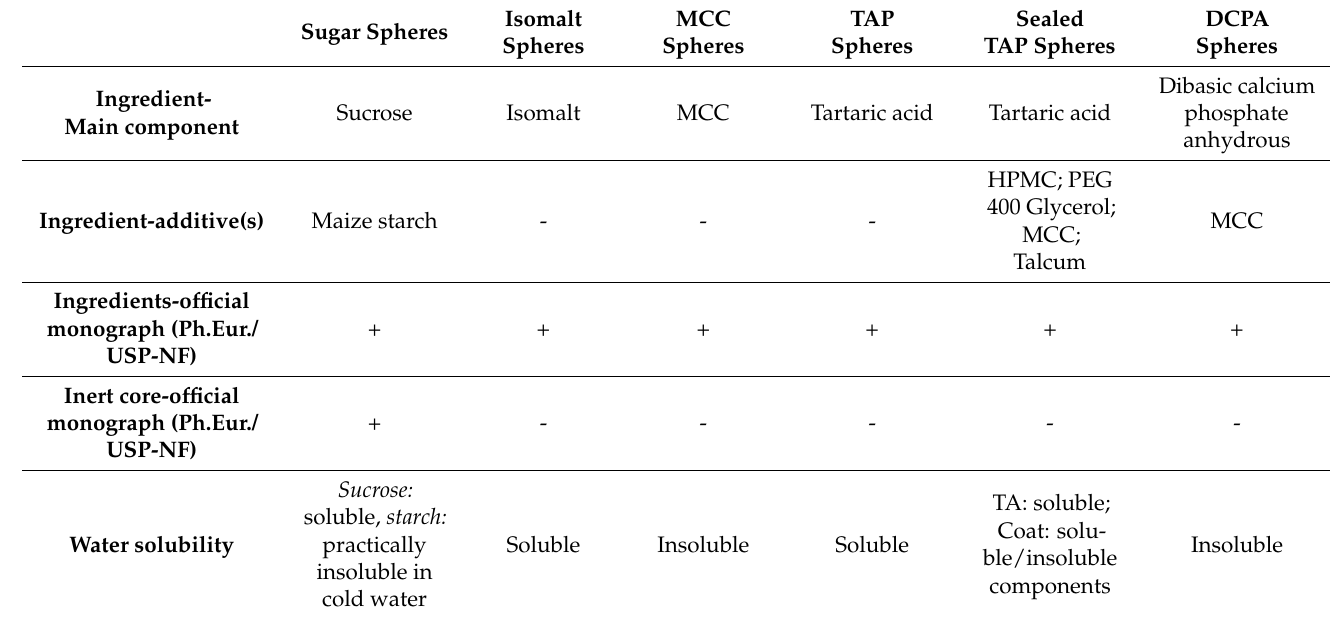
Table 3. Properties of some commonly used starter cores [2,48,58]. (+: present; -: not present). Sugar